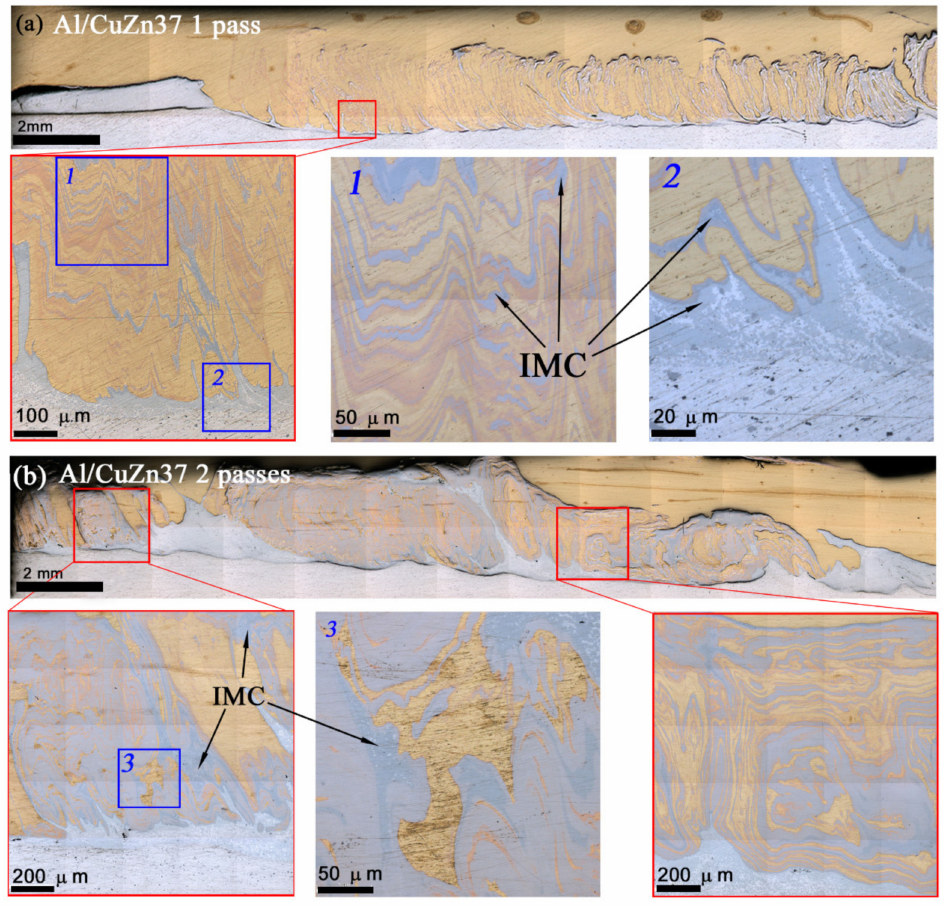
Figure 2. Optical macrographs of AA5056/CuZn37 stir zone obtained after single- ( a ) and double ( b )-pass FSP as viewed along the FSP track